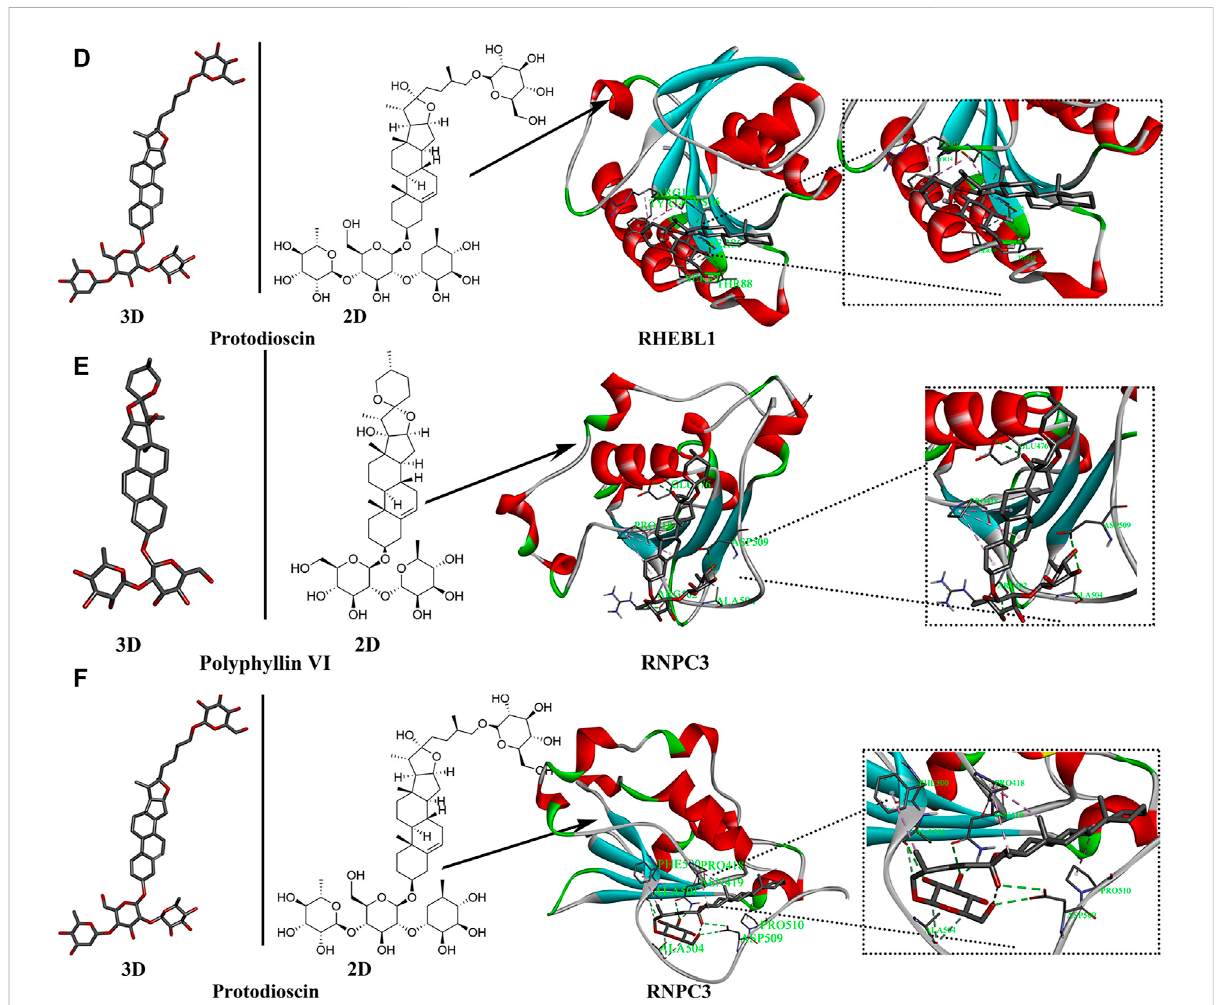
FIGURE 7 Molecular docking screening of relevant active compounds. (A,B) Active compounds with docking scores of − 7 kcal/mol to − 10 kcal/mol with RHEBL1 and RNPC3 proteins. (C,D) Molecular docking of two components (Polyphyllin VI, Protodioscin)and RHEBL1 protein to screen for potential active sites (Polyphyllin VI: LEU123, THR88, SER89, TYR14, ARG15, CYS16. Protodioscin: SER89, THR88, SER86, CYS16, ARG15, TYR14). (E,F) Molecular docking of two components and RNPC3 protein to screen for potential active sites (Polyphyllin VI: ARG505, ALA504 PRO418, GLU476, LYS477. Protodioscin: ARG502, ALA501, ASN419, PRO418, ASP509,